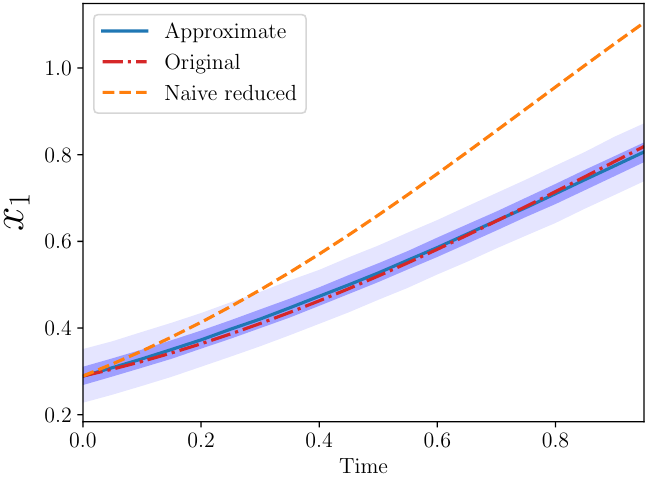
Figure 3. Approximate algebraic model for β = 3, α = 1. Again, the approximate model is a good match to the original for x 1 . Note that ten coefficients from the original model were omitted (eight interaction and two growth rate coefficients), while only two new parameters were introduced, δ 1 and δ 2